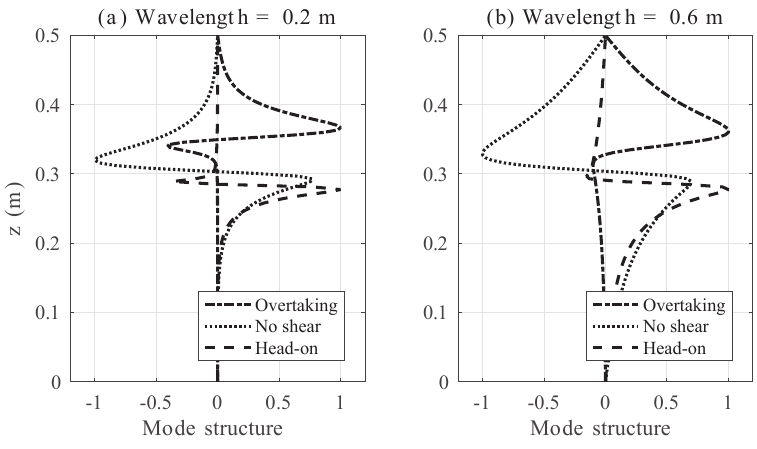
Figure 9. Same as Fig. 7 but for mode-2